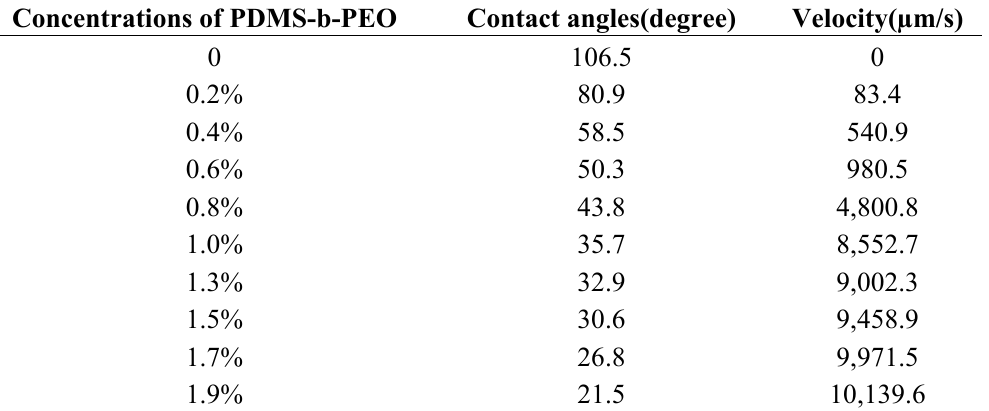
Table 1. The meniscus moving in the capillary channel (100 µm wide, 28 mm long) with different velocities due to the different PEO-PDMS of different contact